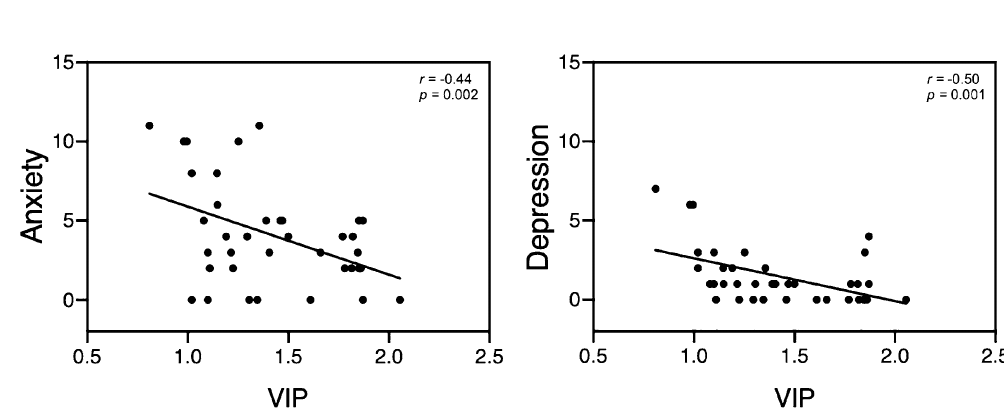
Figure 2. VIP Pearson correlations with Hospital anxiety and depression scale (HADS), p-values derived from non-parametric bootstrapping. VIP vasoactive intestinal polypeptide.